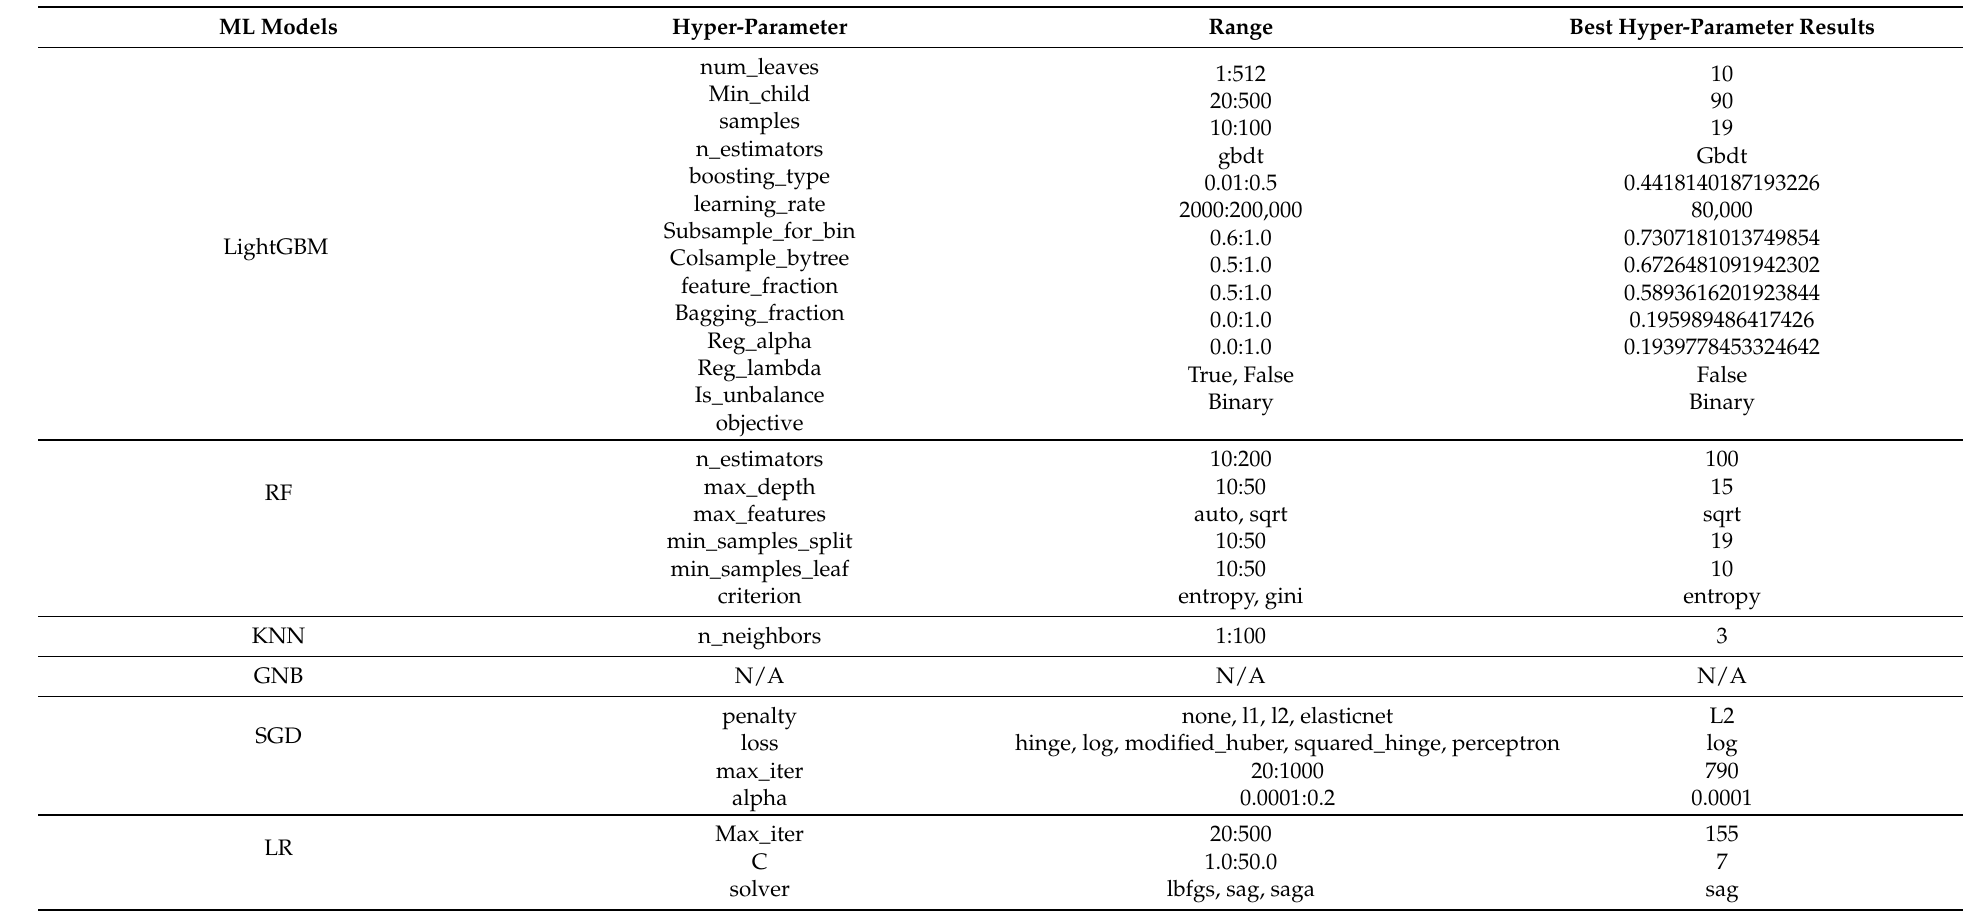
Table 13. ML Models Hyper-parameter results using AHBO-TPE (Kaggle